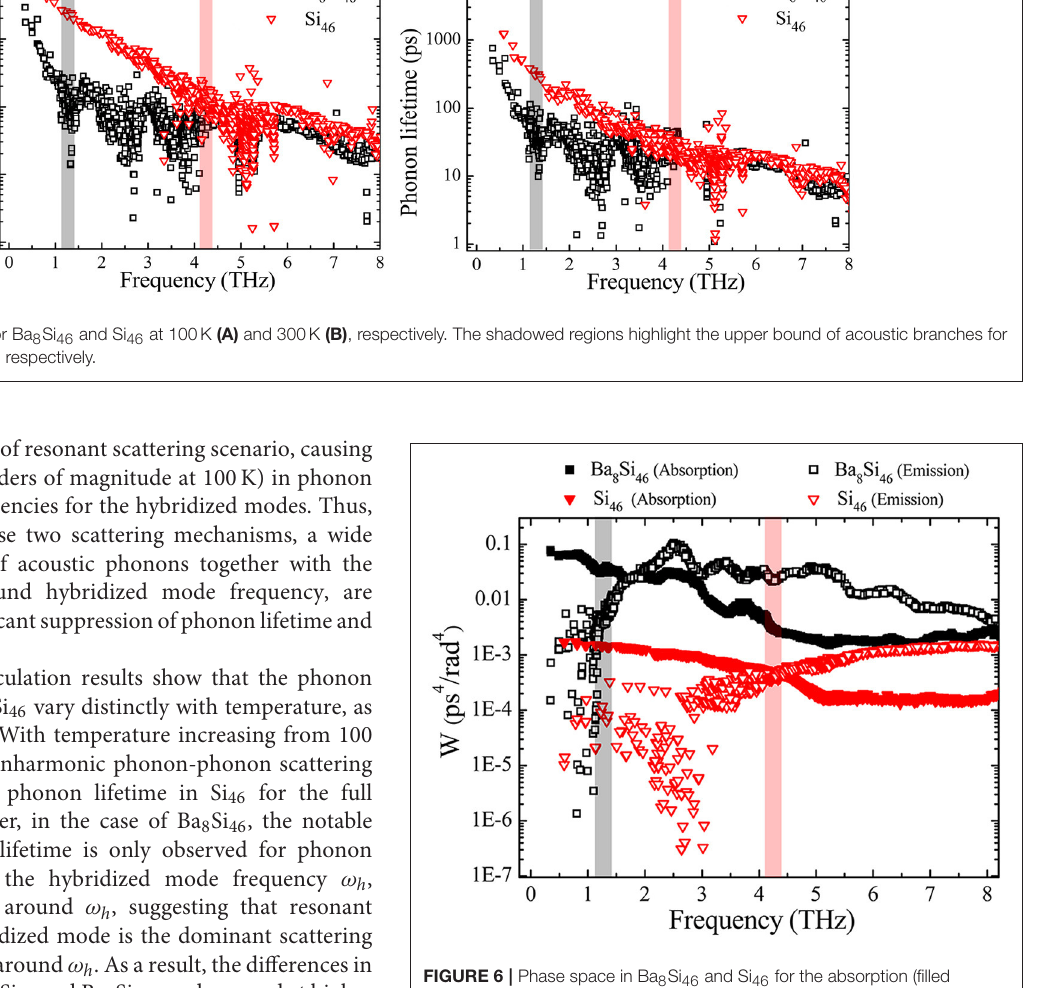
FIGURE 6 | Phase space in Ba 8 Si 46 and Si 46 for the absorption (filled symbols) and emission (empty symbols) process at 100K. The shadowed regions highlight the upper bound of acoustic branches for Ba 8 Si 46 (black) and Si 46 (red),